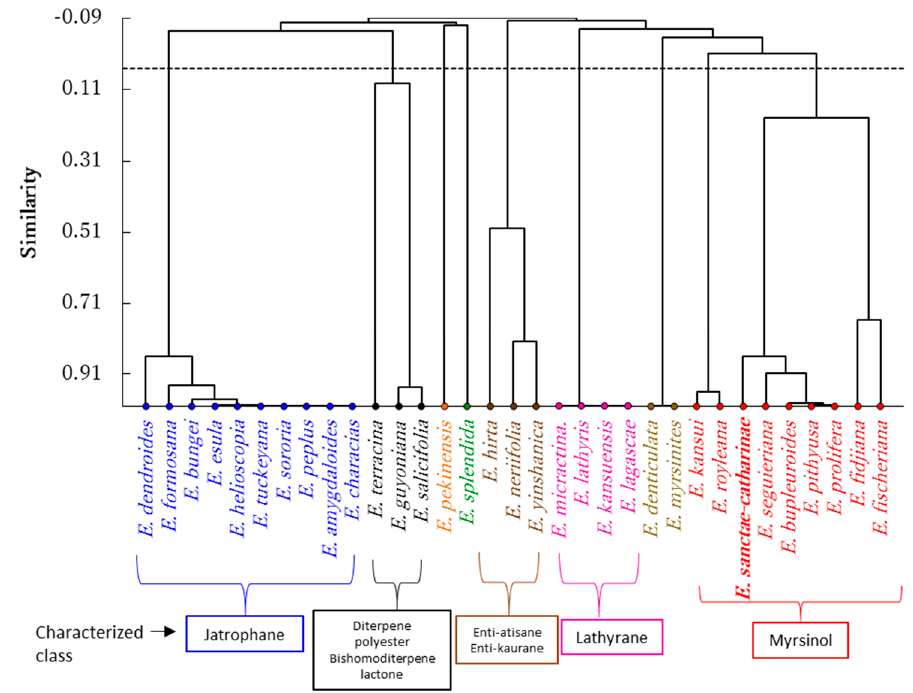
Figure 4. Agglomerative hierarchical clustering (AHC) of 32 Euphorbia species and the present studied endemic Euphorbia ( E. sanctae-catharinae ) based on the terpenoid compounds.